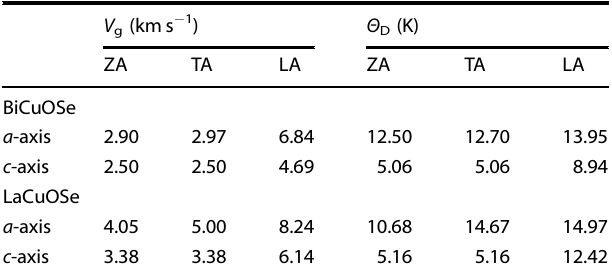
Table 3. The calculated phonon velocities V g and Debye temperatures Θ D of out-of-plane acoustic branches (ZA), transverse acoustic branches (TA) and longitudinal acoustic branches (LA) for BiCuOSe and